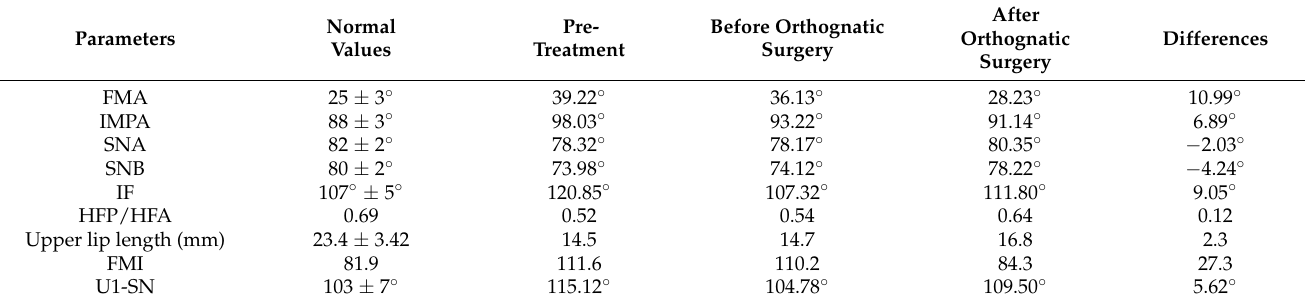
Table 1. Pre and post treatment cephalometric